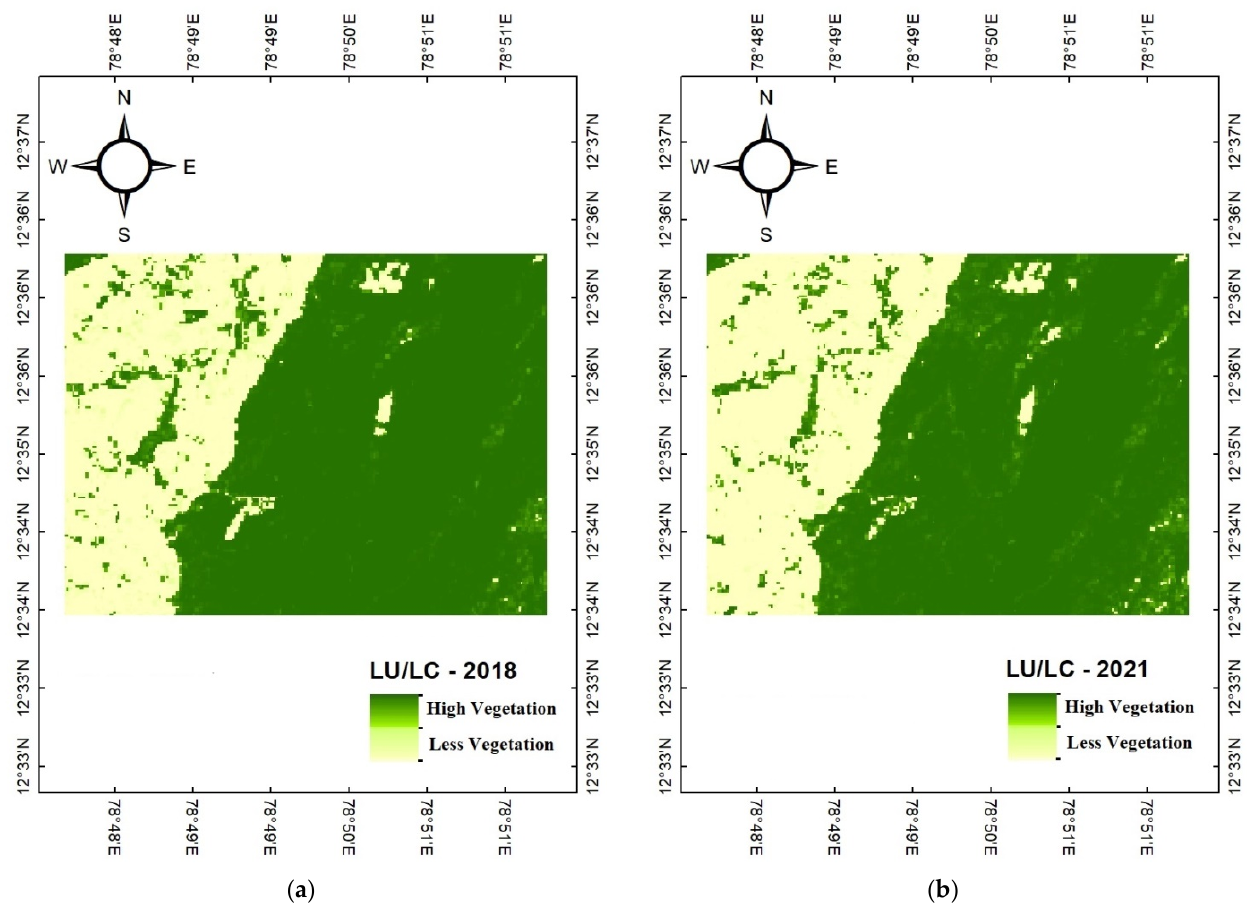
Figure 13. LU/LC prediction map of Javadi Hills for the years ( a ) 2018 and ( b ) 2021.